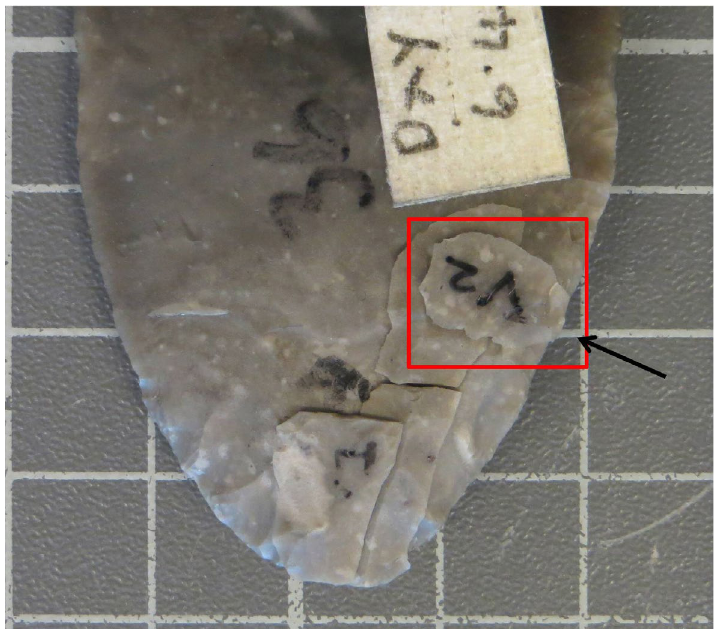
Figure 13. Blade-point 5.19, flake v2 with the black arrow indicating the direction of removal blow (photograph by the author). Gridlines on this image are 10mm